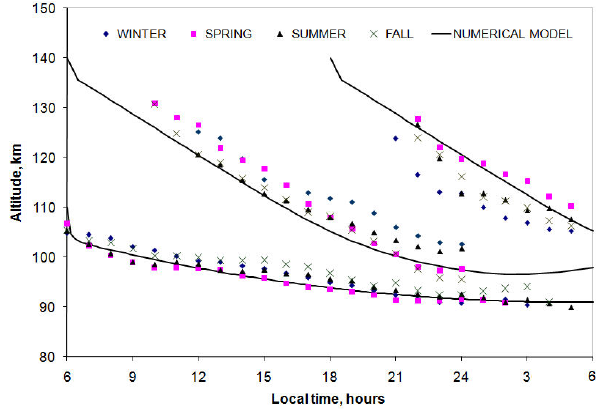
Fig. 9. Windshear numerical simulation results for a diurnal S(1,1) – λ z =27.9km (lower solid line trace), and a semidiurnal S(2,6) – λ z =33km (upper solid line traces) zonal tidal wind modes, super- imposed over the observed mean E s traces presented for all seasons in Figs. 4 to 7 and Fig. 8. The tidal modes are released near 06:00LT at 110km and 140km for the diurnal and semidiurnal tide, respec- tively. See text for more